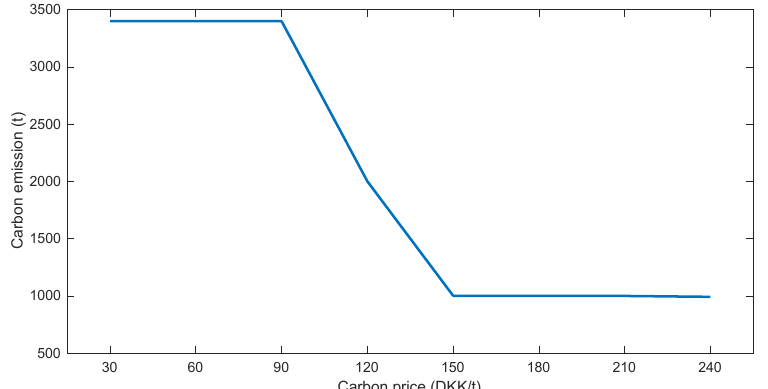
Figure 13. Total carbon emissions under different carbon trading prices.